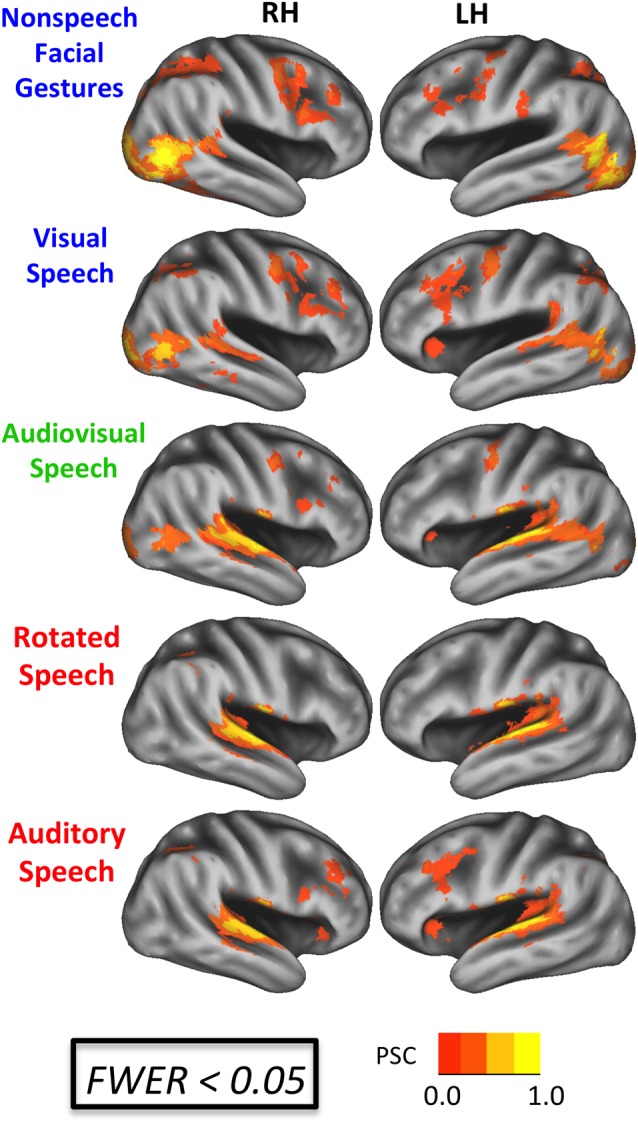
BOLD effects during each experimental condition. Results are shown on an inflated surface rendering of the study-specific template in MNI space. Top: speech conditions (A, V, AV). Bottom: nonspeech conditions (R, G). All maps thresholded at an uncorrected voxel-wise p < 0.005 with a cluster threshold of 185 voxels (family-wise error rate (FWER) corrected p < 0.05). PSC, percent signal change.